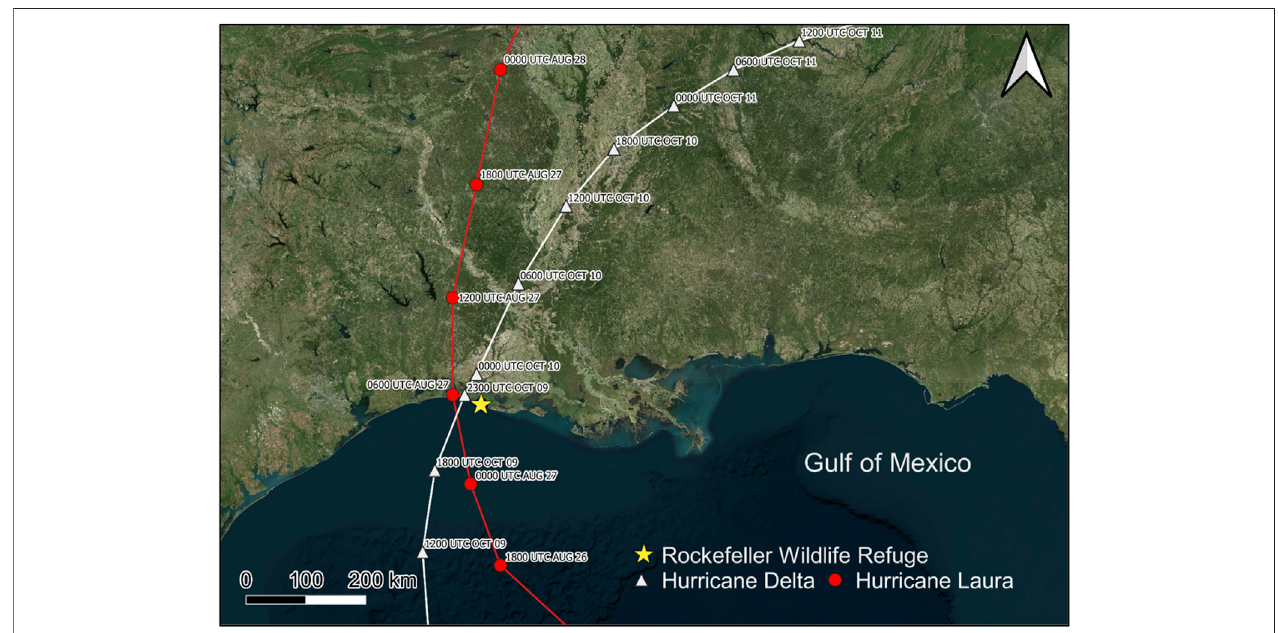
FIGURE 1 | Location of the study site, Rockefeller Wildlife Refuge (yellow star), on the Louisiana coastline and the time-stamped (UTC) paths of Hurricane Delta (white triangles) and Hurricane Laura (red circles) (Basemap: Satellite imagery courtesy of the U.S. Geological Survey, Google Earth Engine).